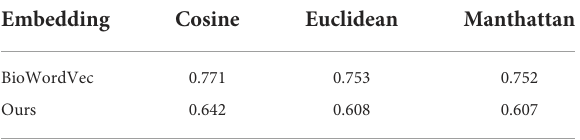
TABLE 3 Comparison between proposed embeddings (ours), and the state-of-the-art model (BioWordVec) for the sentence pair similarity